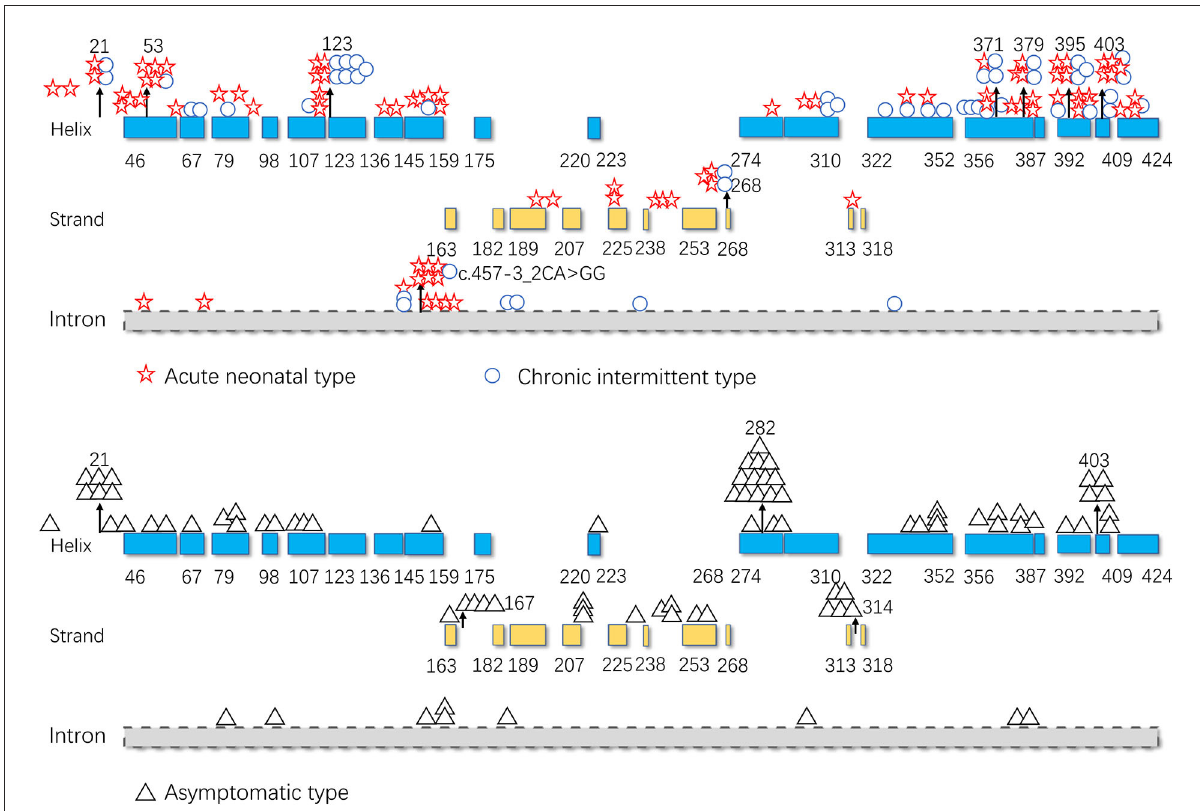
FIGURE5 Distribution of the isovaleryl-CoA dehydrogenase (IVD) variants. Blue: the α -helical N-terminal domain and the second α -helical C-terminal domain of IVD; yellow: the β -sheet domain; and gray: intron region. Numbers represent the corresponding amino acid